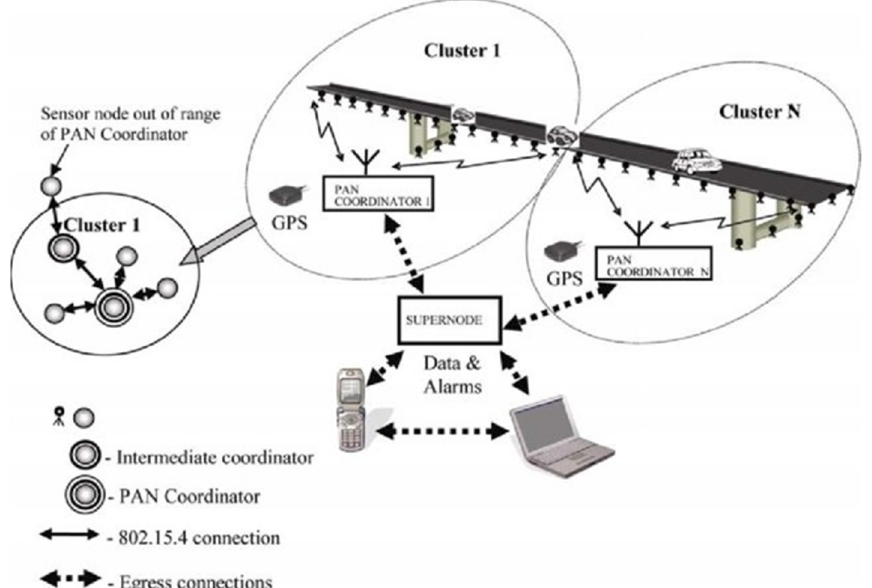
Figure 8. The hierarchical wireless sensor network for structural health monitoring in bridge struc- tures [66].